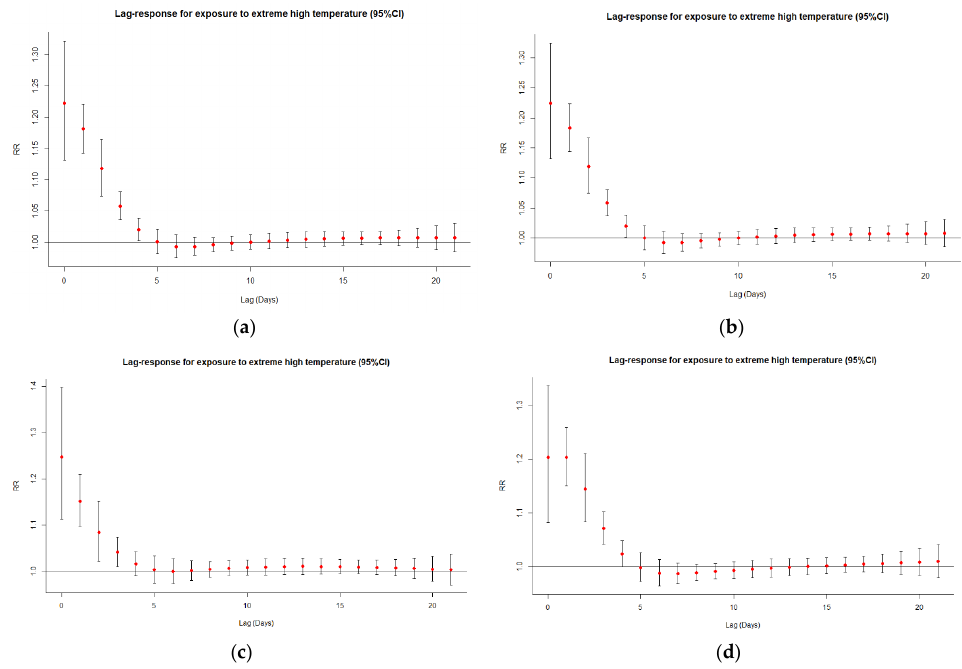
Figure 4. Lag-response curves for exposure to extreme heat (95% CI) for ( a ) the total population, ( b ) the elderly, ( c ) males, and ( d ) females.